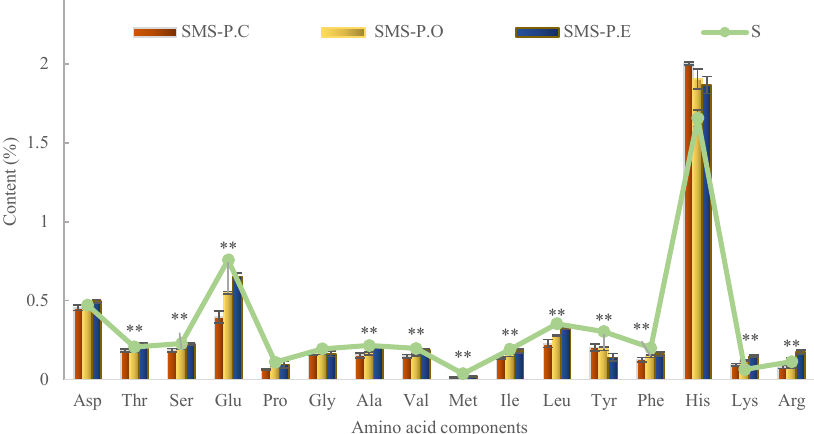
Figure 2. Changes in amino acid components in substrate (S) and spent mushroom substrates (SMS). SMS-P.C, SMS-P.O, and SMS-P.E indicated SMS from P. eryngii , P. ostreatus, and P. citrinopileatus. Amino acid components included alanine (Ala), arginine (Arg), aspartic acid (Asp), tyrosine (Tyr), glutamic acid (Glu), glycine (Gly), histidine (His), isoleucine (Ile), leucine (Leu), lysine (Lys), methionine (Met), phenylalanine (Phe), proline (Pro), serine (Ser), threonine (Thr), and valine (Val). ** indicated significance of amino acid among SMS at 0.05